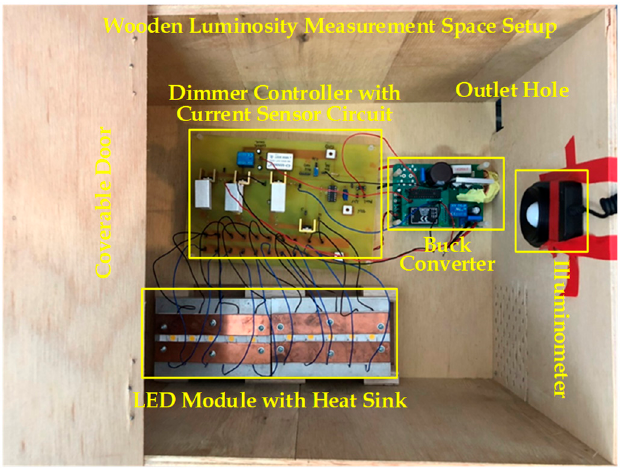
Figure 11. Photograph of the photometric environment.